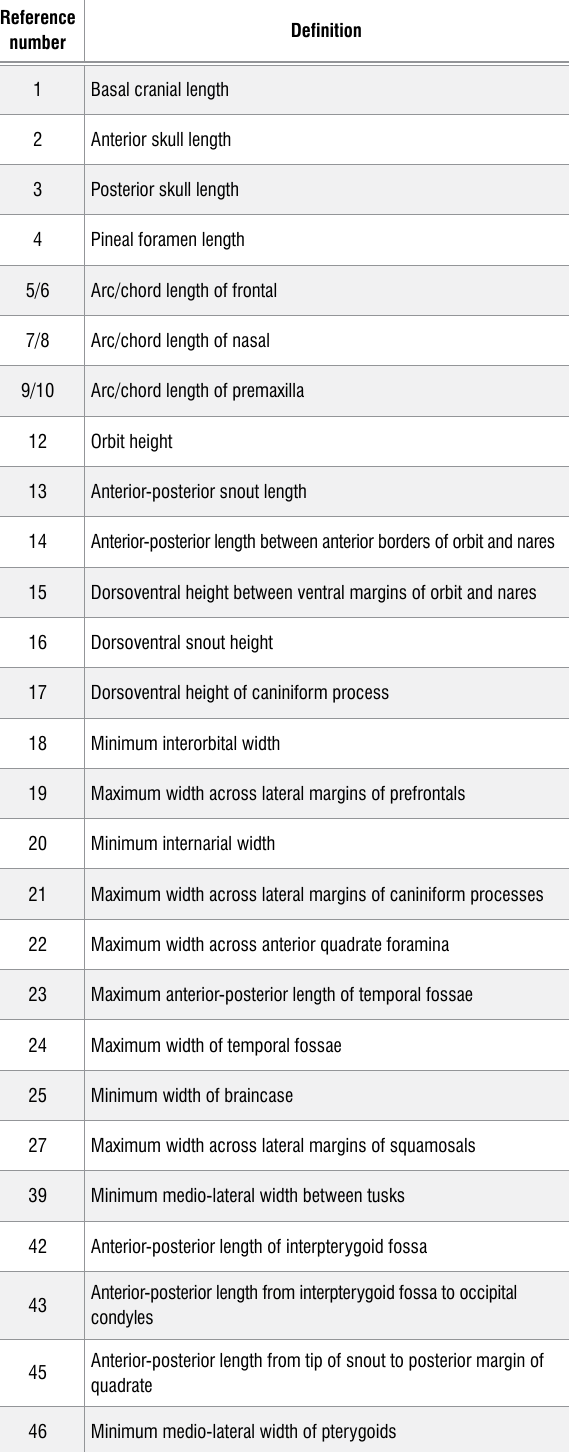
Table 1: Cranial dimensions used in this study. Reference numbers (with definitions) are those given by Camp